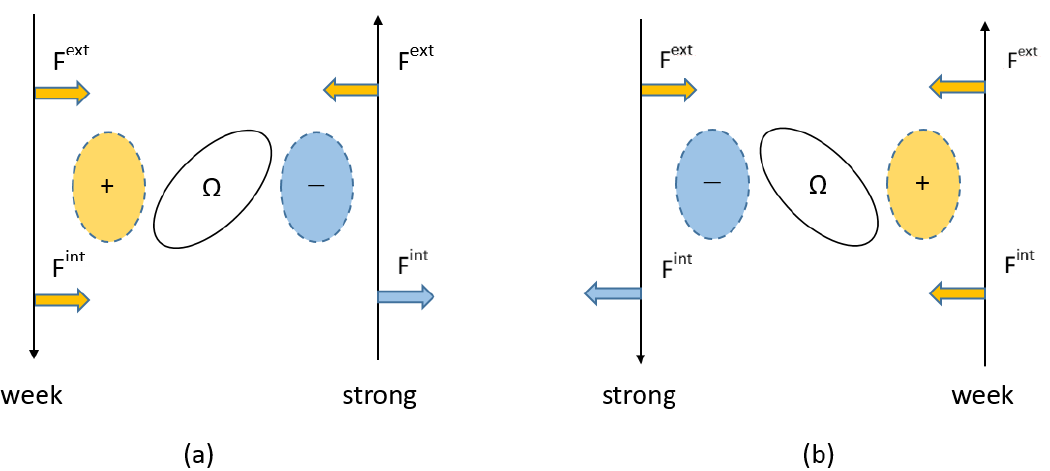
Figure 11. Schematic illustrations of dislocation interaction of Type-B variant with different orien- tations in ( a , b ). Assuming positive external stress in ( a , b ), force vectors associated with external and internal stress, F ext and F int , change their directions according to the dislocation tangent vector indicated by upper and lower arrows. Dislocation motion under the positive external stress is always promoted or retarded by positive and negative internal stresses, respectively.